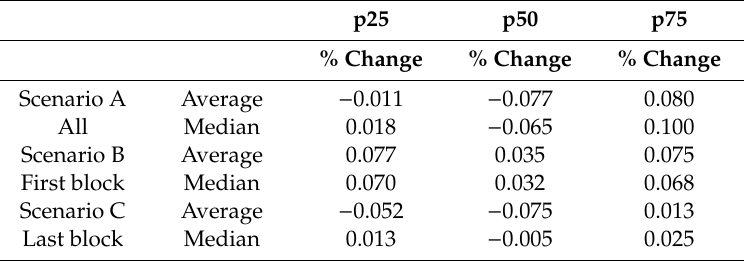
Table 9. Complete e ff ect of price changes in di ff erent